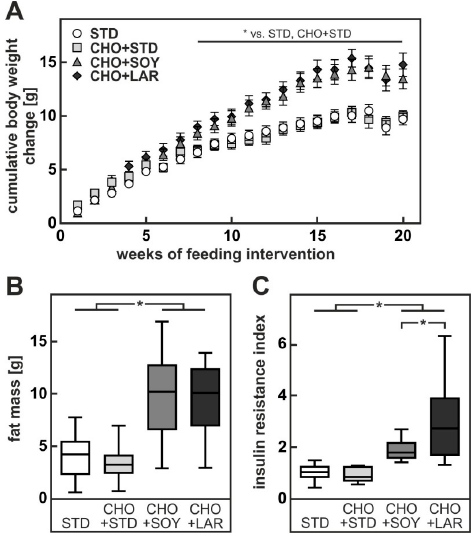
Figure 1. Increase in body weight, fat mass and insulin resistance in mice fed a CHO + SOY or CHO + LAR diet for 20 weeks. ( A ) Cumulative body weight change. ( B ) Fat mass in week 20. ( C ) Insulin resistance index was calculated by the sum of the products of insulin concentration × glucose concentration during the oral glucose tolerance test. Values are median (line), upper- and lower quartile (box) and extremes (whiskers) of 17–35 ( A , B ) or 8–10 ( C ) mice per group. Statistics: Multiple Student’s t -test for unpaired samples ( A ) or one-way-ANOVA with Tukey’s post hoc test for multiple comparisons ( B , C ). * p < 0.05.